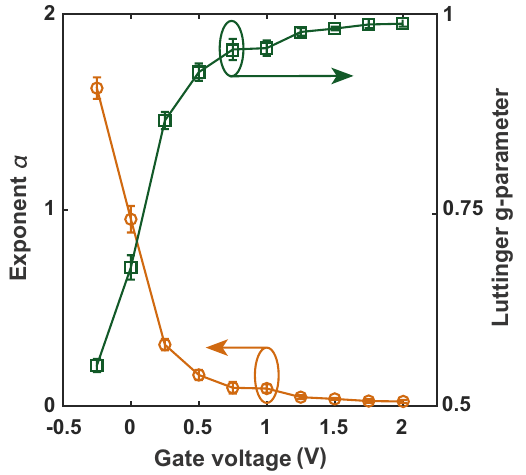
Figure 4. Voltage exponent for 1D transport. The measured voltage exponent α and Luttinger g -parameter extracted from the slope of the normalized conductance plotted on the T -renormalized